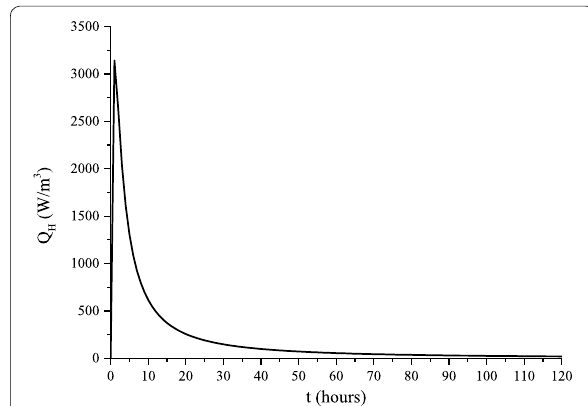
Fig. 8 Time evolution of the volumetric heat flux in the concrete considering the hydration of the